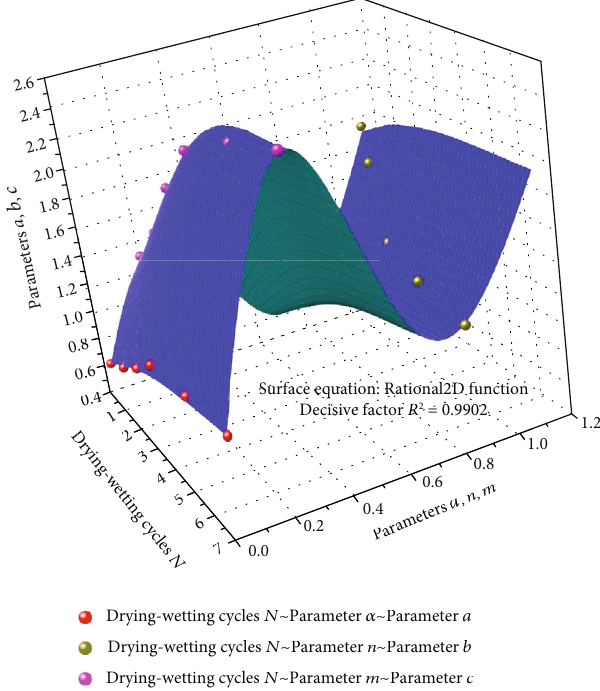
Figure 11: Relationship between SWCC curve parameters and POSD parameters under di ff erent drying – wetting